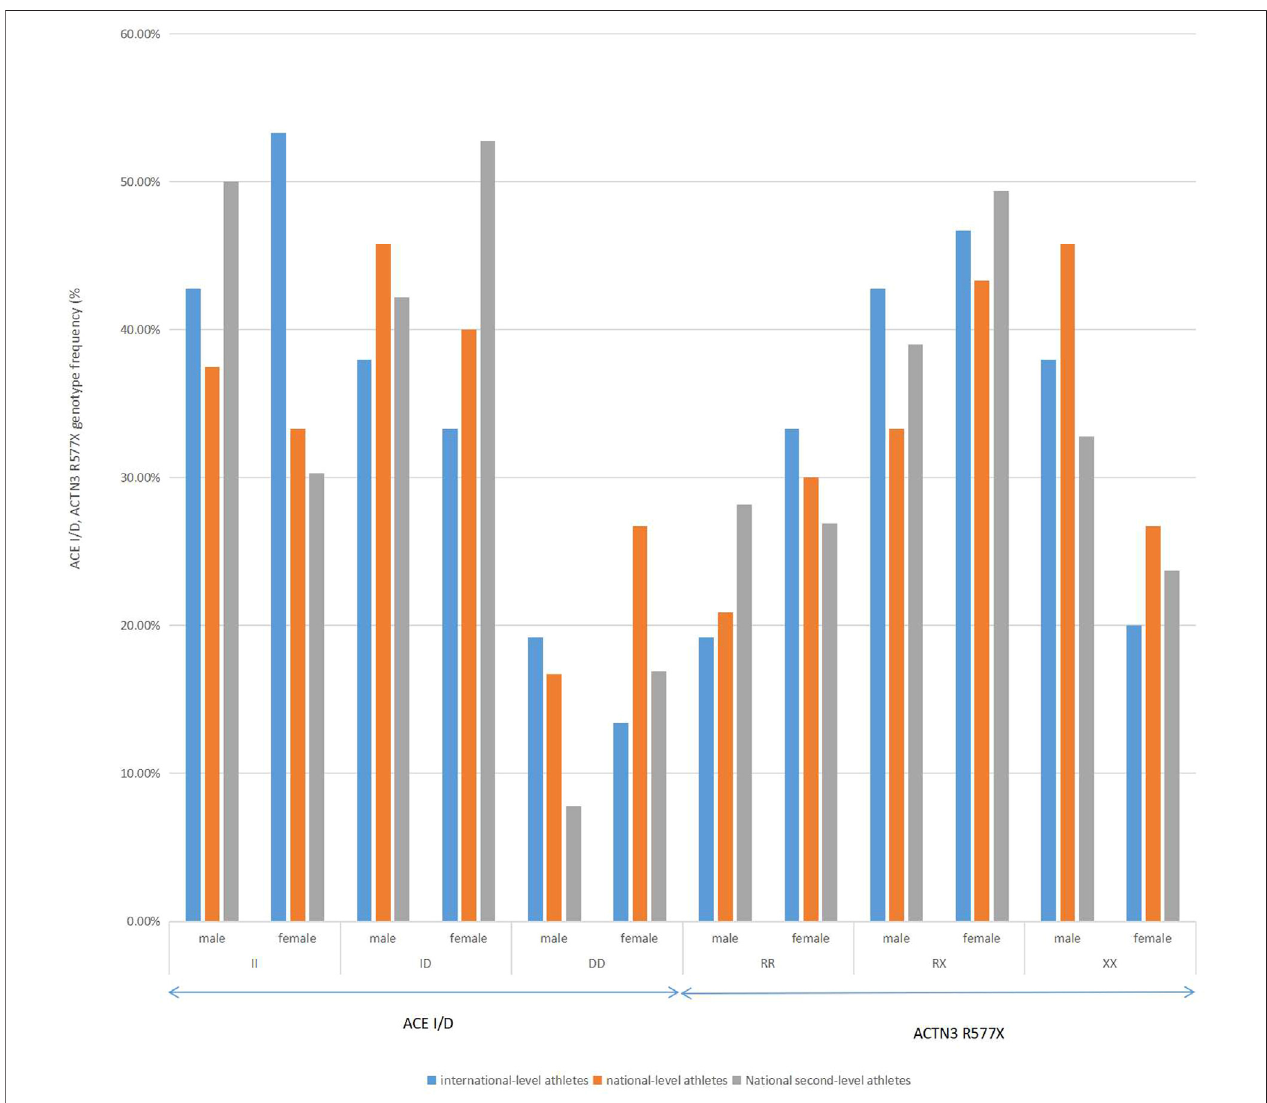
FIGURE2 | Distributionof ACTN3 genepolymorphisminmaleinternational-levelathletes,national-levelathletes,andnationalsecond-levelathletesofrowinginChina.